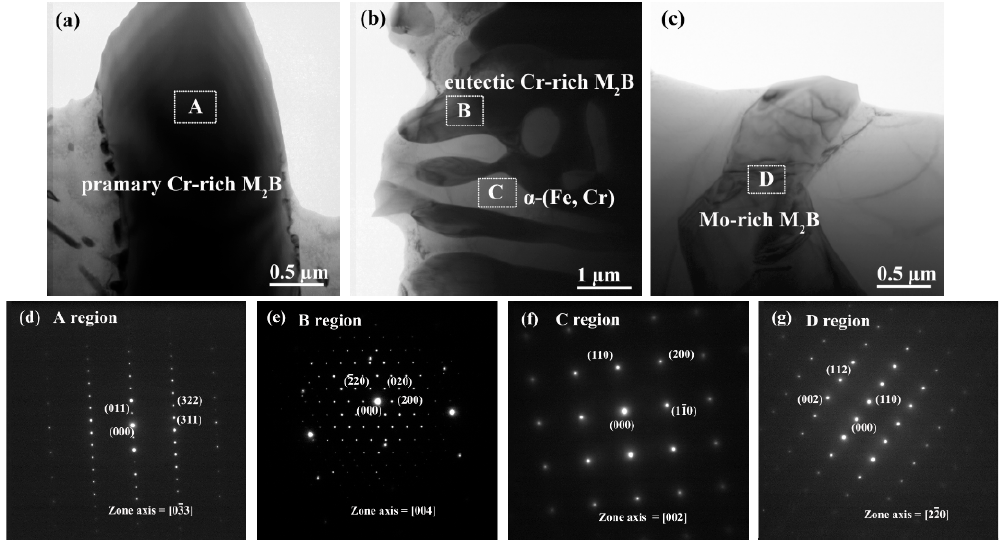
Figure 4. Transmission electron microscopy (TEM) analysis of alloy M4: ( a – c ) Bright-field TEM micrographs and corresponding SADPs of borides and matrix: ( d ) corresponding SADPs from primary Cr-rich M 2 B boride reflected from [033], ( e ) corresponding SADPs from eutectic Cr-rich M 2 B boride reflected from [004], ( f ) corresponding SADPs from α -(Fe, Cr) matrix reflected from [002], ( g ) corresponding SADPs from Mo-rich M 2 B boride reflected from [22